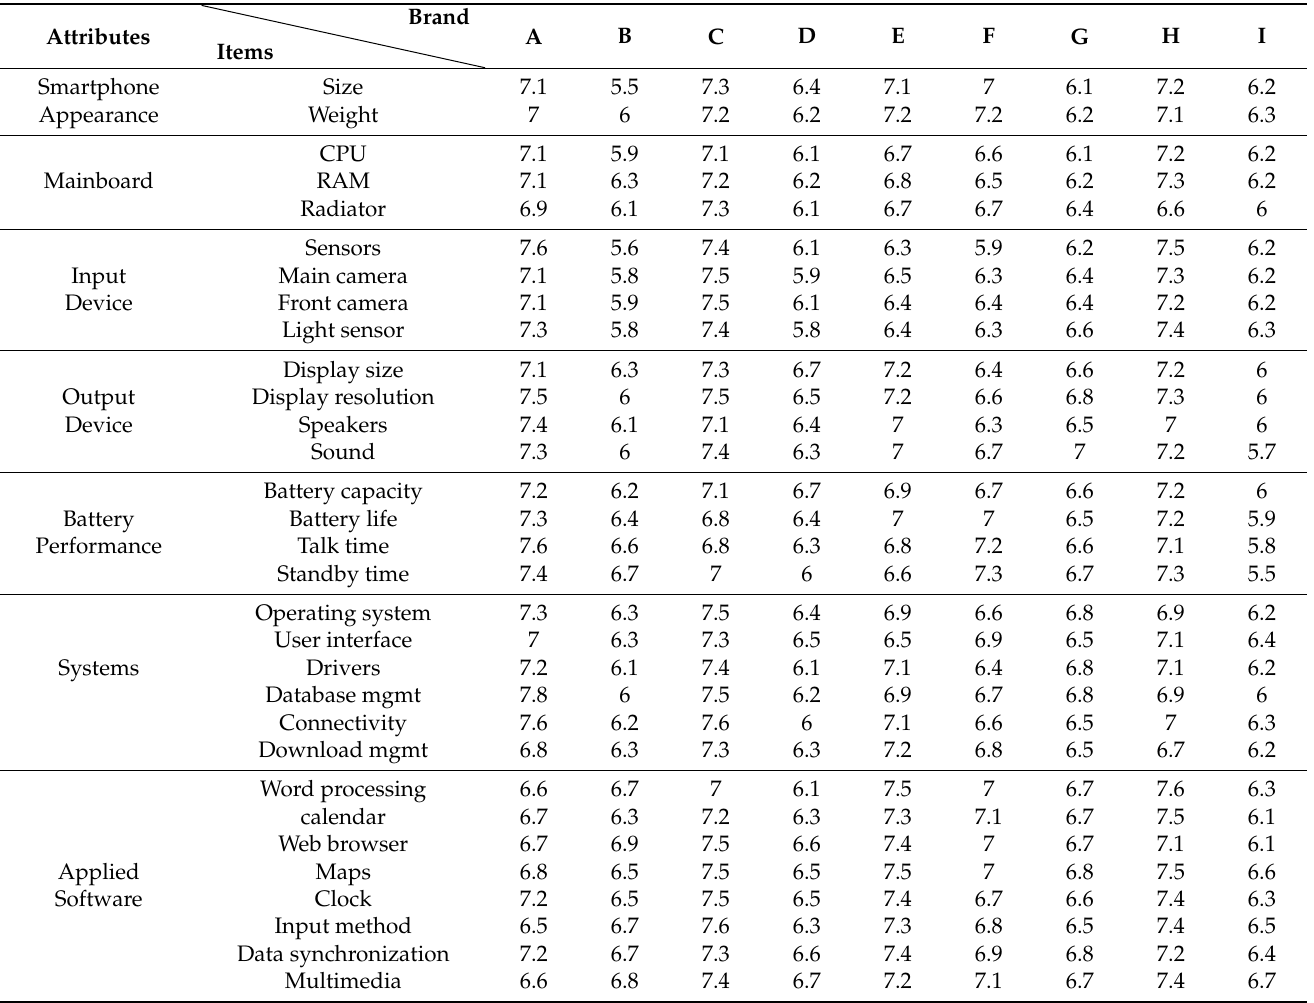
Table 1. Original matrix of the